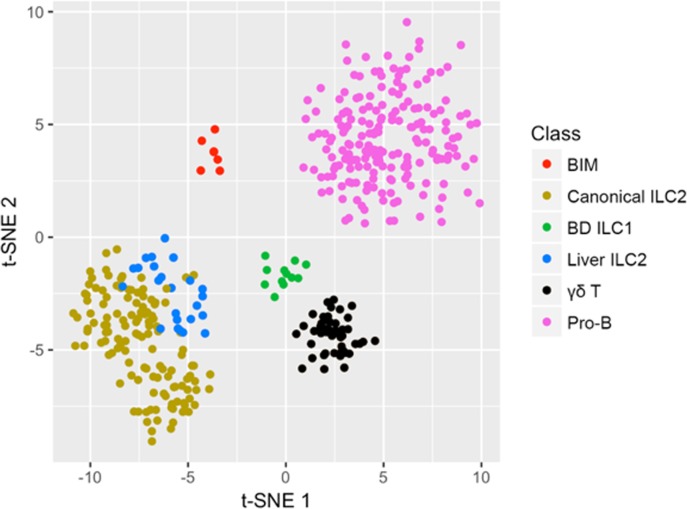
BIM are distinct from ILC2.Stochastic neighbor embedding plot (t-SNE) utilizing the top 200 genes in each major cell class shows the distinct position of BIM and its relatedness to other IL-33-induced hepatobiliary CD45+Linneg mononuclear cell classes.